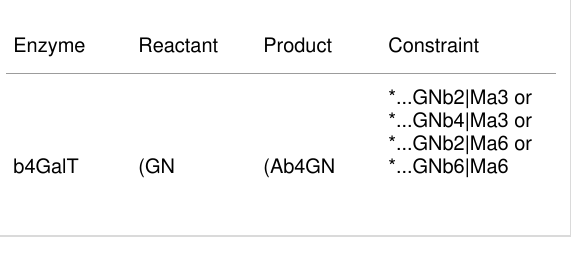
Table 8: The reaction rule (GN → (Ab4GN with four constraints written on separate lines.